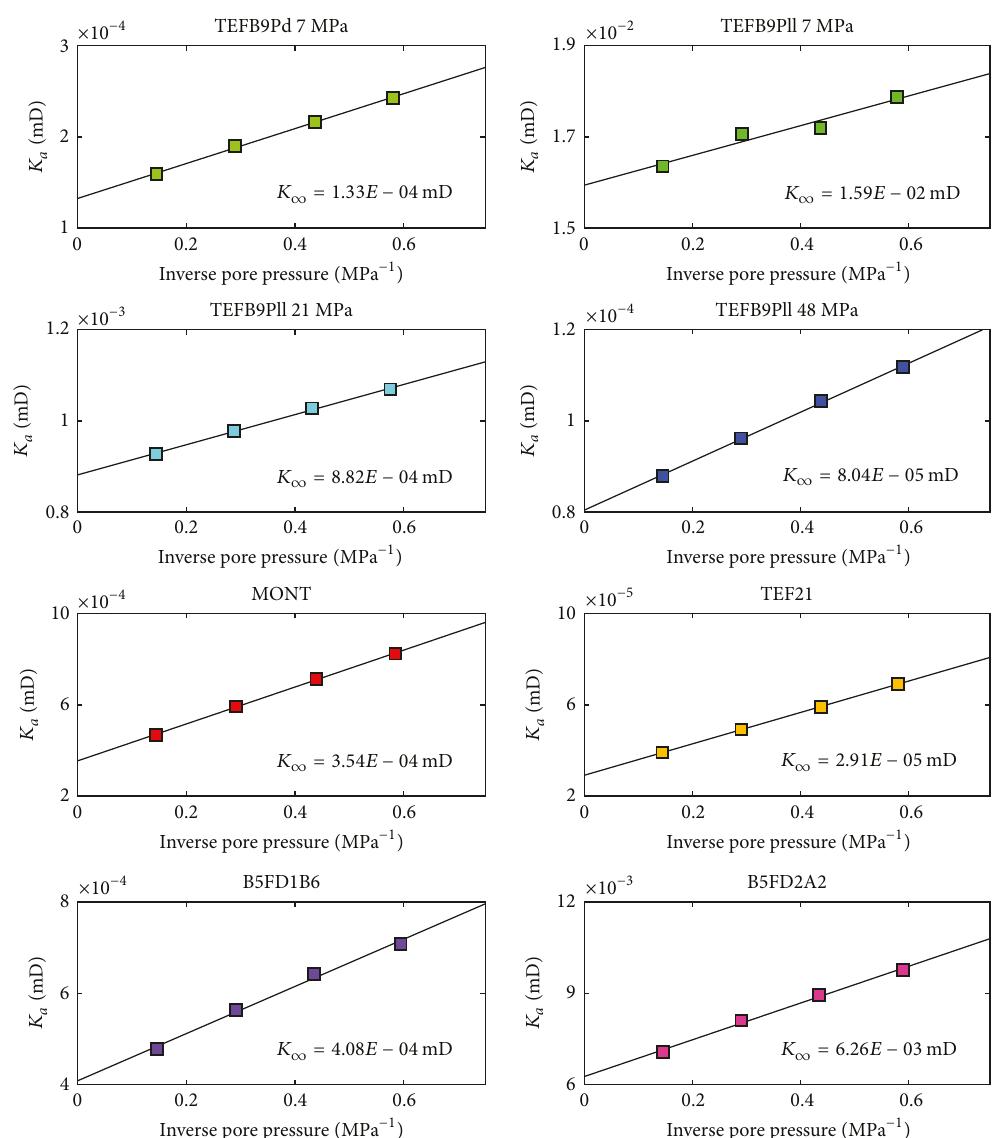
Figure 5: Klinkenberg plot for each sample generated using the helium permeability